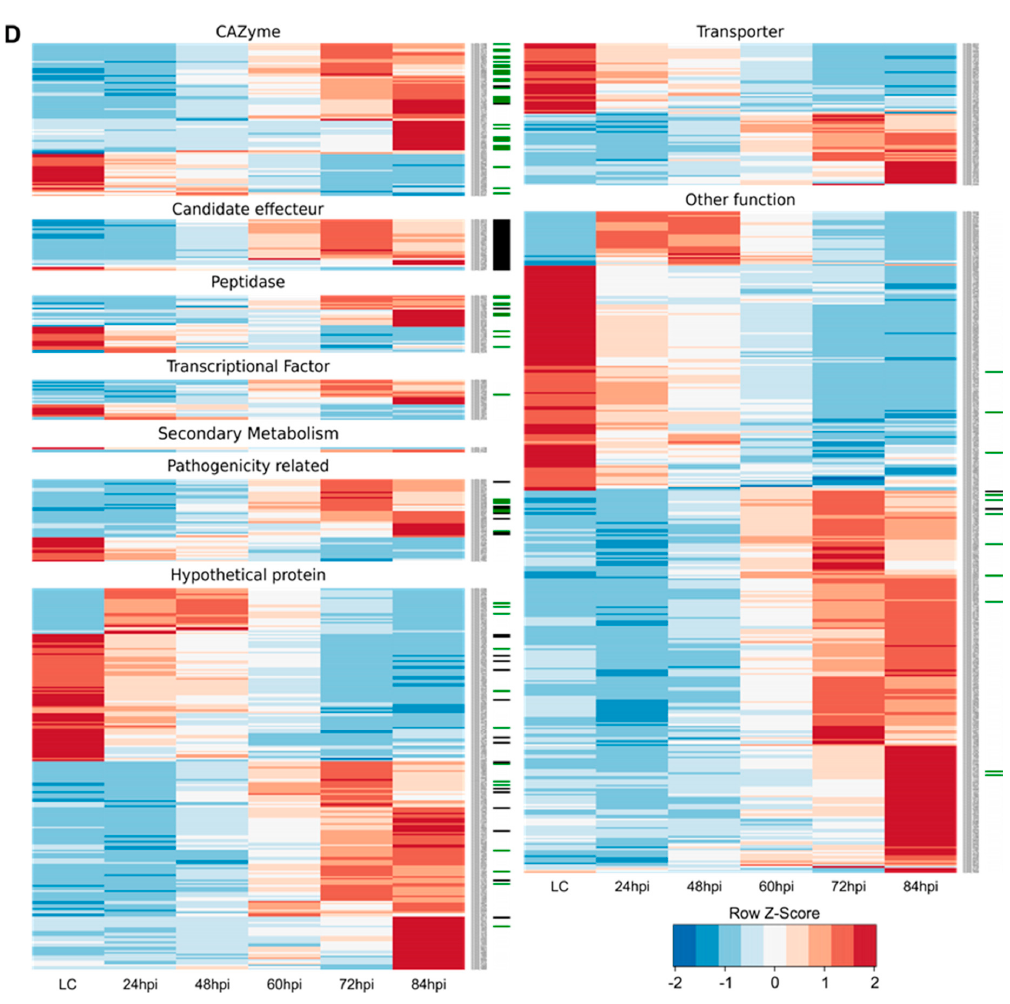
Figure 1. Overview of the phenotypic and molecular C. lupini infectious process. ( A ) Lupin inoculated with water (top) and with RB221 (bottom) at 84 hpi. ( B ) Germinated conidia (Cn) of the strain RB221 on lupin epidermis with appressorium (Ap) at 12 hpi (top) and formation of a primary hyphae (Ph) and a thinner secondary hyphae (Sh) at 48 hpi (bottom). Fungal structures were colored by lactophenol cotton blue and the length of the scale bar is 10 µm. ( C ) Evolution of the size of necrosis caused by C. lupini on lupin hypocotyl for 84 hpi. ( D ) Heatmap of 897 C. lupini DEGs compared to liquid culture (LC) (LFC < − 1 and > 1, FDR < 0.05), grouped by putative functional class. Pathogenicity-related genes included stress response genes, Nudix, NEP and other functions described as associated with pathogenicity. Colored bars indicated gene expression by Z-score calculated from normalized reads of DEGs, and ranging from − 2 (downregulated gene, blue) to 2 (upregulated gene, red). The green or black rectangles at the right of each gene represent genes respectively predicted as encoding secreted proteins or small secreted